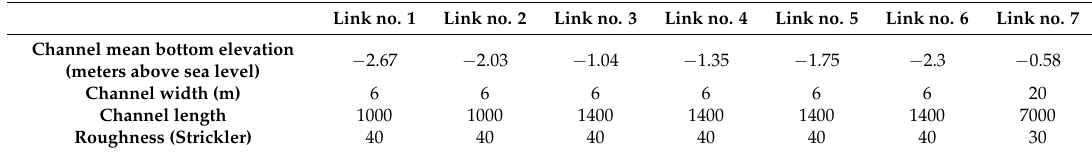
Figure 8. ( a ) Comparison between simulated and observed pumping discharges. ( b ) Rainfall intensity trend during the extreme event in March 2011. Table 3. Hydraulic parameters after the calibration of the model upstream from the Mazzocchio pumping system (data provided by Agro Pontino Reclamation Consortium (APRC)).